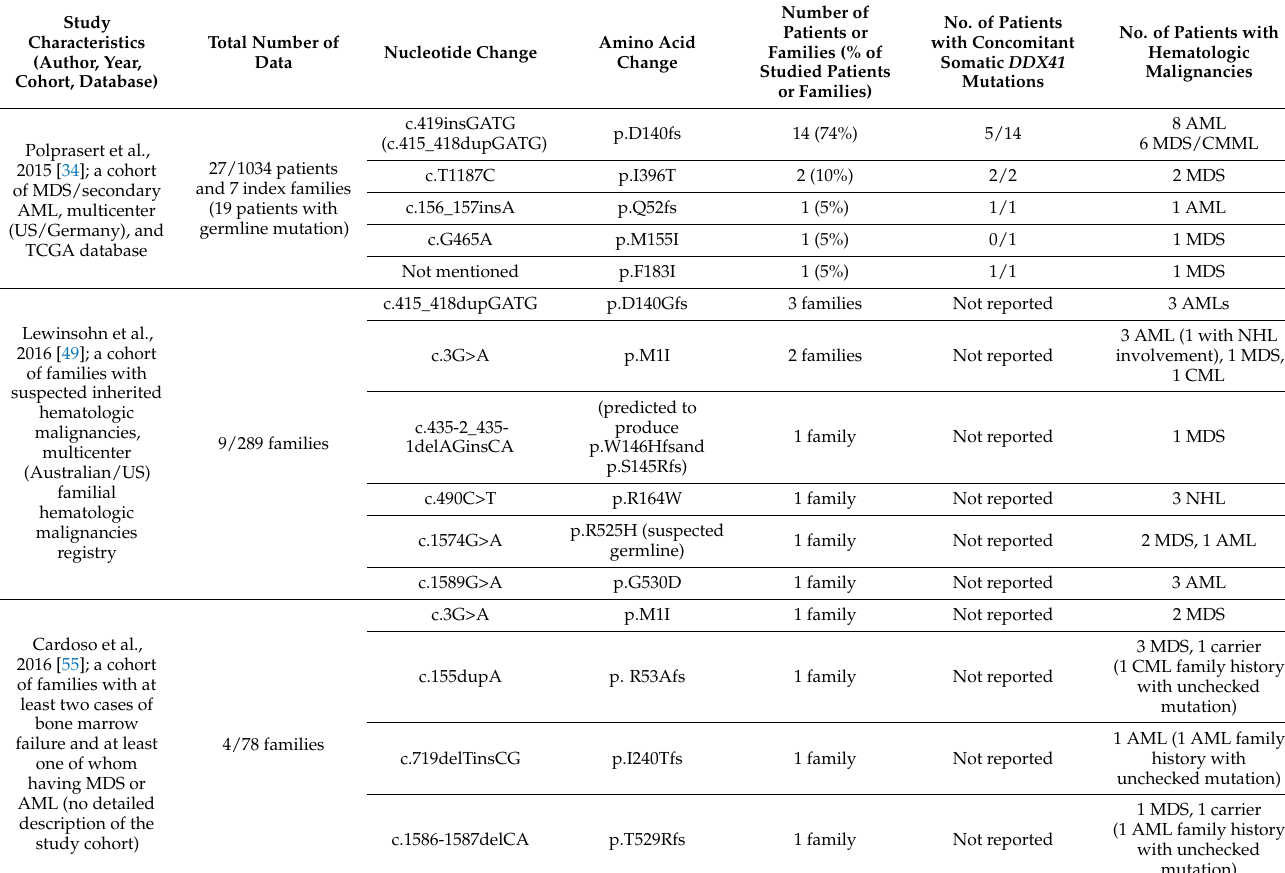
Table 1. Summary of DDX41 studies and identified germline